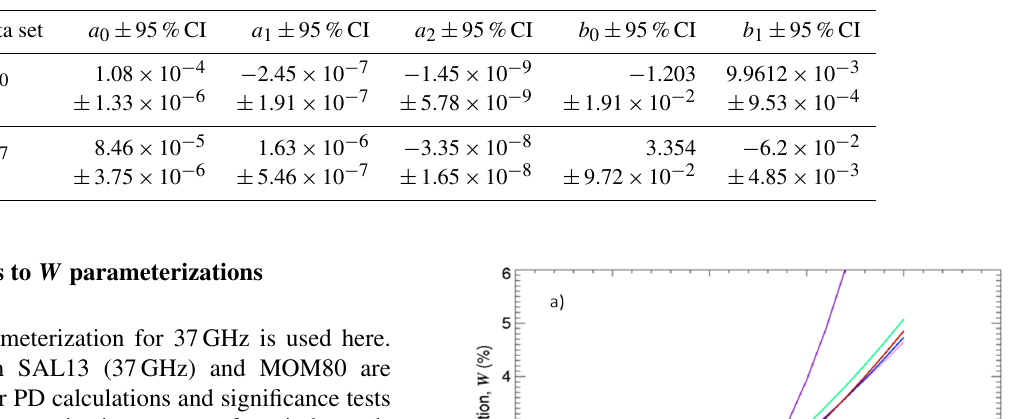
Table 5. Coefficients for the SST dependence of the parametric coefficients a and b in Eq. (14) with their 95% CIs from the fitting procedure. The temperature-dependent parametric coefficients a(T ) and b(T ) are used in parameterization W(U 10 ,T ) (Eq. 13) derived from satellite- based W data for 10 and 37GHz for 2006.